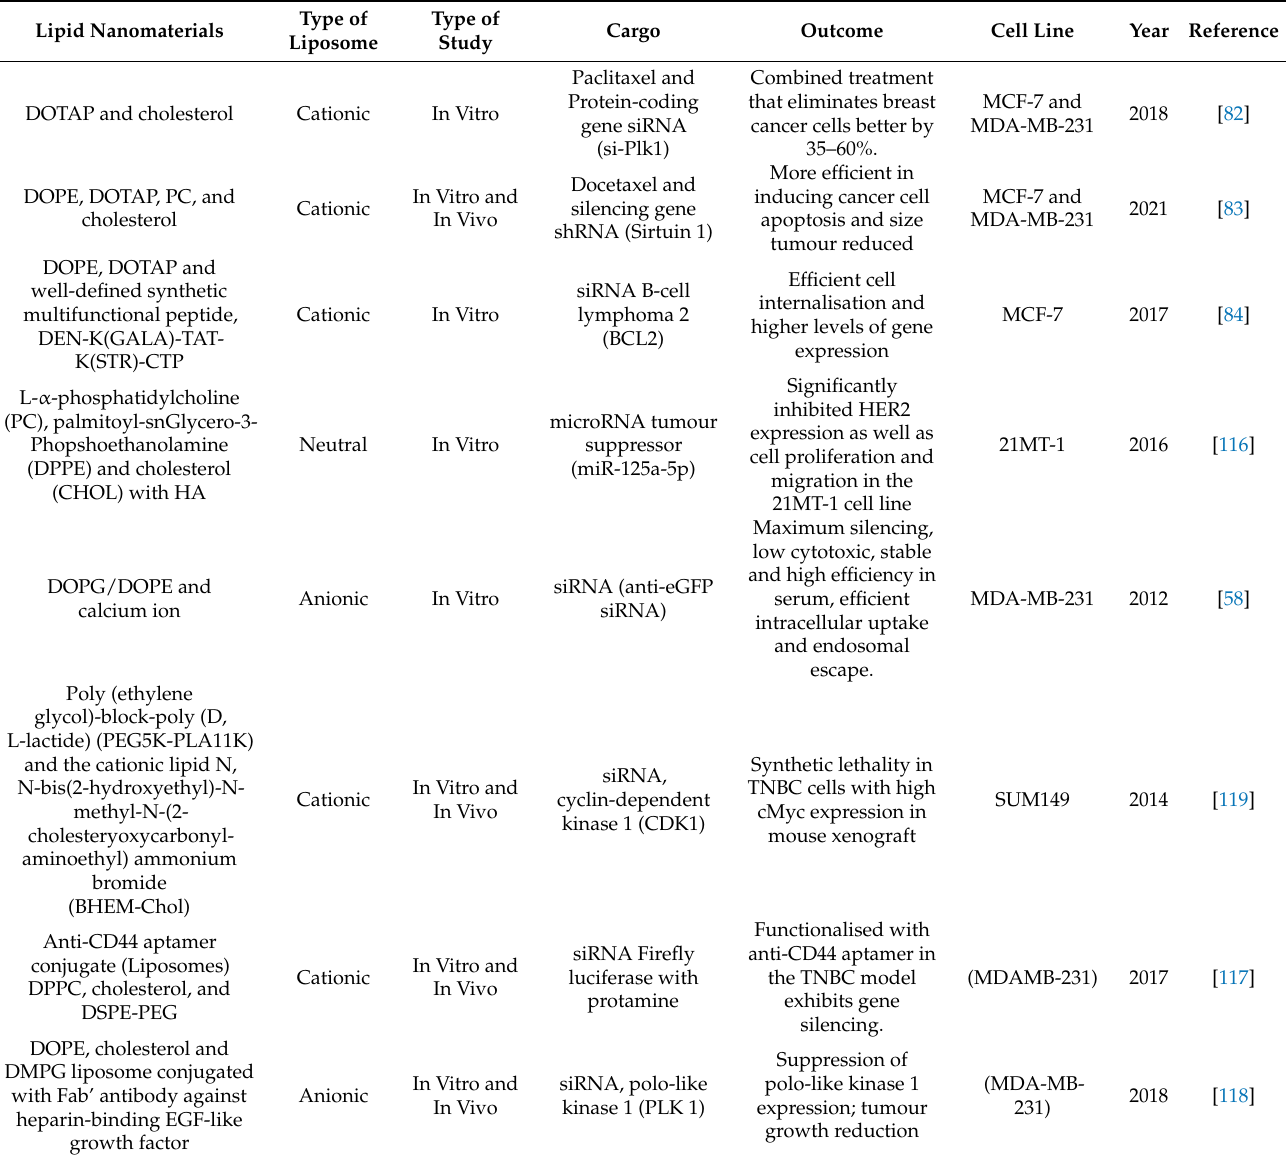
Table 8. Successful liposome formulations tested on breast cancer cell lines with gene cargo and their type of study reported in